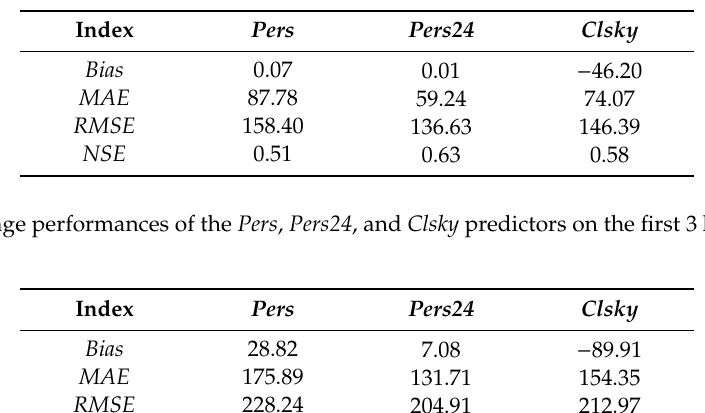
Table 1. Average performances of the Pers , Pers24 , and Clsky predictors on the first 3 hours (whole day).